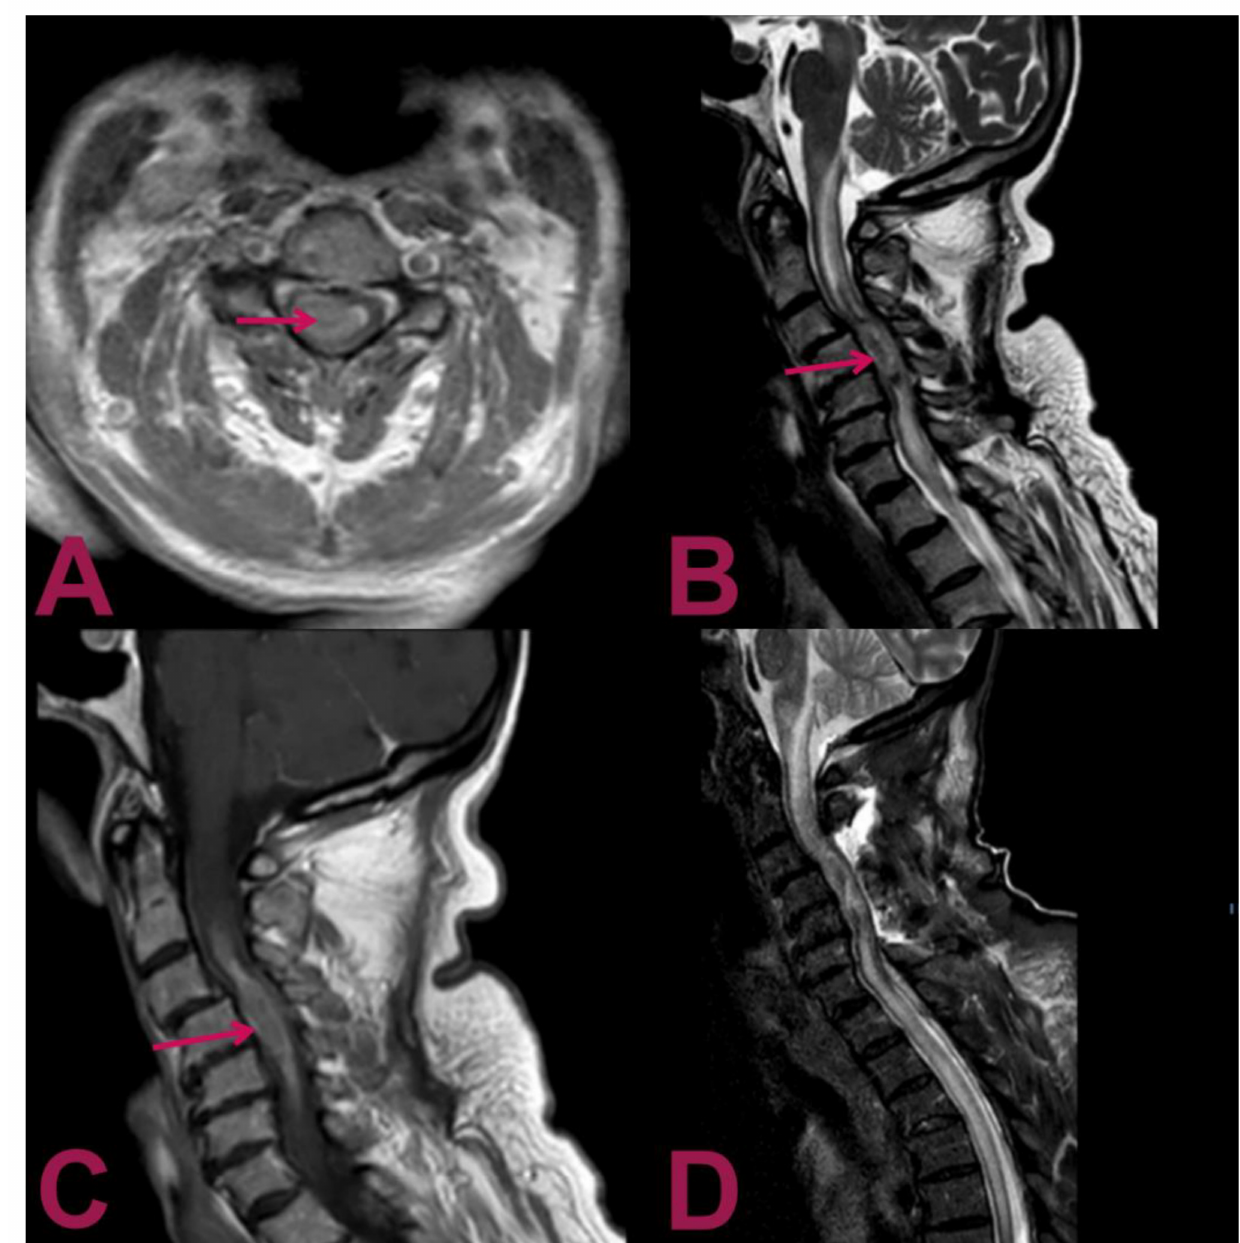
Figure 1. Magnetic resonance imaging (MRI) of the cervical spine. ( A ) Gadolinium-enhanced T1-weighted axial MRI shows an intra-axial lesion containing hemosiderin (arrow) with predominant right paramedian development. ( B ) T2-weighted sagittal MRI shows an extensive syringomyelic cavity, which covers the caudal portion of the floor of the IV ventricle and affects the posterior portion of the bulb–medullar junction extending up to the D5 level inferiorly. The syringomyelic cavity is the result of the newly formed tissue extending from C4 level for about 6 cm with a maximum diameter of about 15 mm (arrow). ( C ) Gadolinium-enhanced T1-weighted sagittal MRI displays the intramedullary mass at the C2–C6 level with a heterogeneous contrast enhancement pattern (arrow). ( D ) Postoperative T2-weighted sagittal MRI reveals the outcomes of hemilaminectomy C3–C4–C5 and cervical myelotomy with partial removal of the lesion; noticeably, despite the invasive nature of the surgical intervention, the previous parameters have not deteriorated; no worsening in the syringomyelic cavity is present, and the peri-wound oedema is not